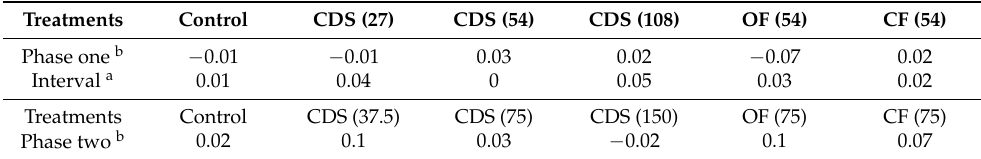
Table 8. Soil TP loss of the treatments in phase one and two (g/kg).